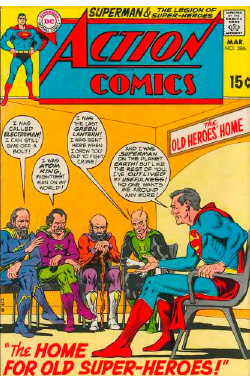
Figure 7. Action Comics #386, “The Home for Old Super-Heroes!” (March 1970) [10] .